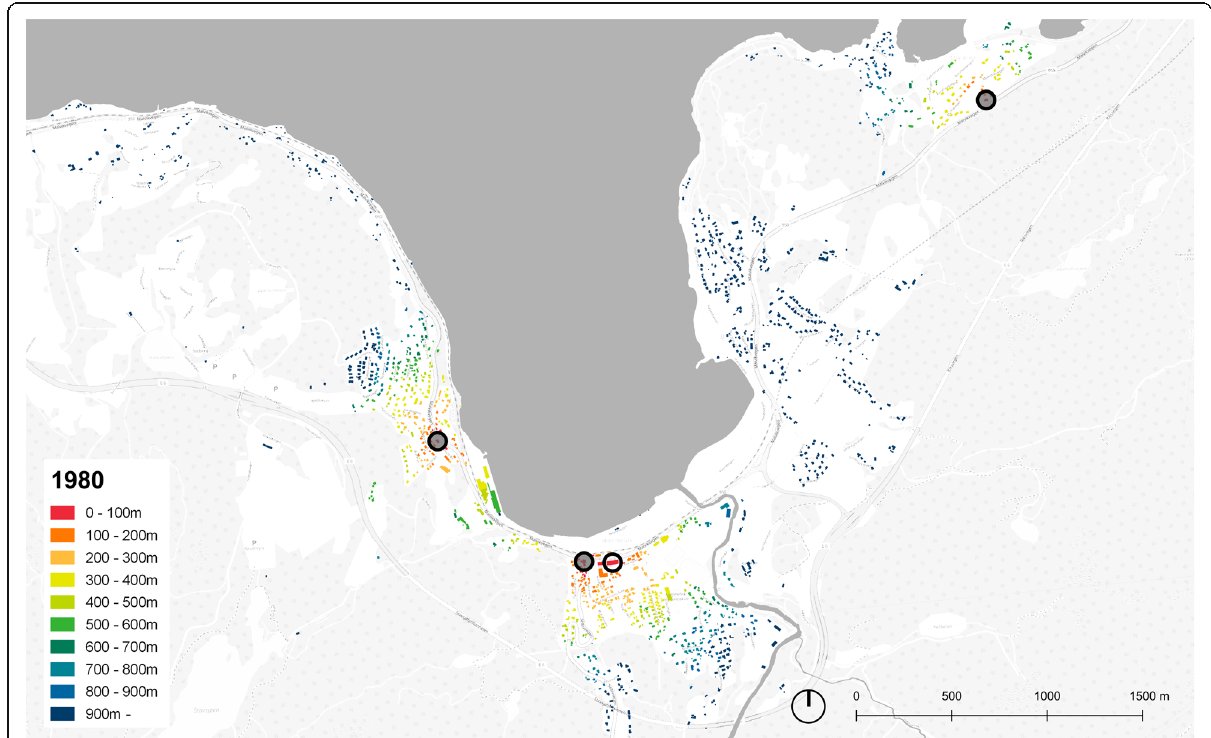
Fig. 3 Distance to grocery stores, Hommelvik, 1980. Stores marked with circles, filled circles representing stores closed down since